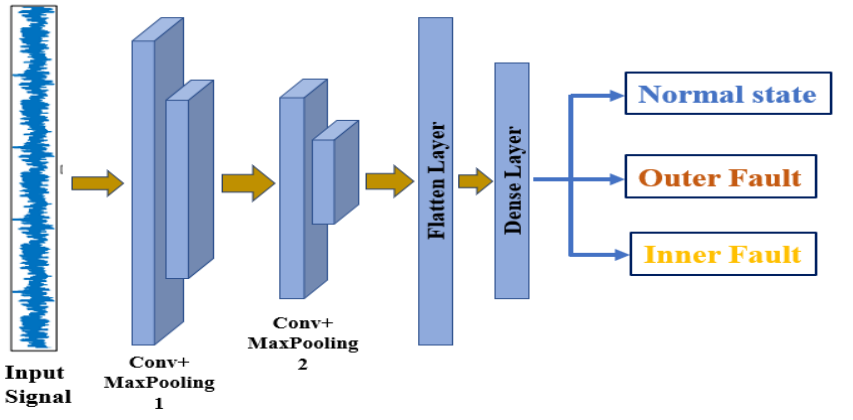
Figure 7. Architecture of the designed CNN.